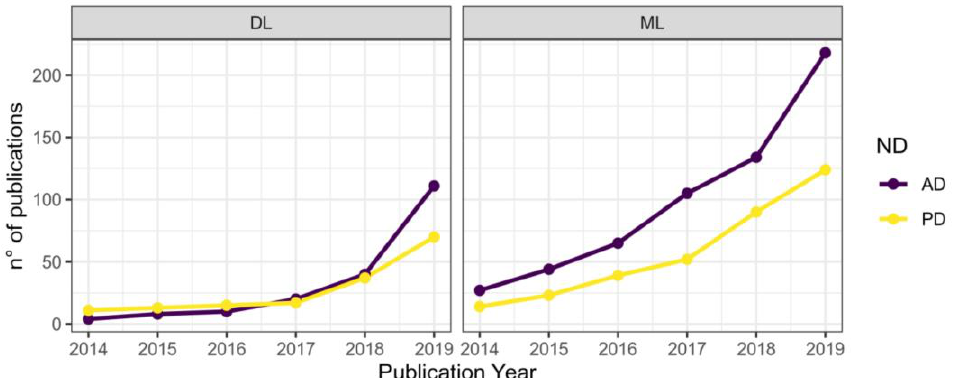
Figure 1. The number of publications on the applications of machine learning ( right ) and deep learning ( left ) to diagnostics of Parkinson’s disease (yellow graph) and Alzheimer’s disease (purple graph) by year (reproduced from [4]).